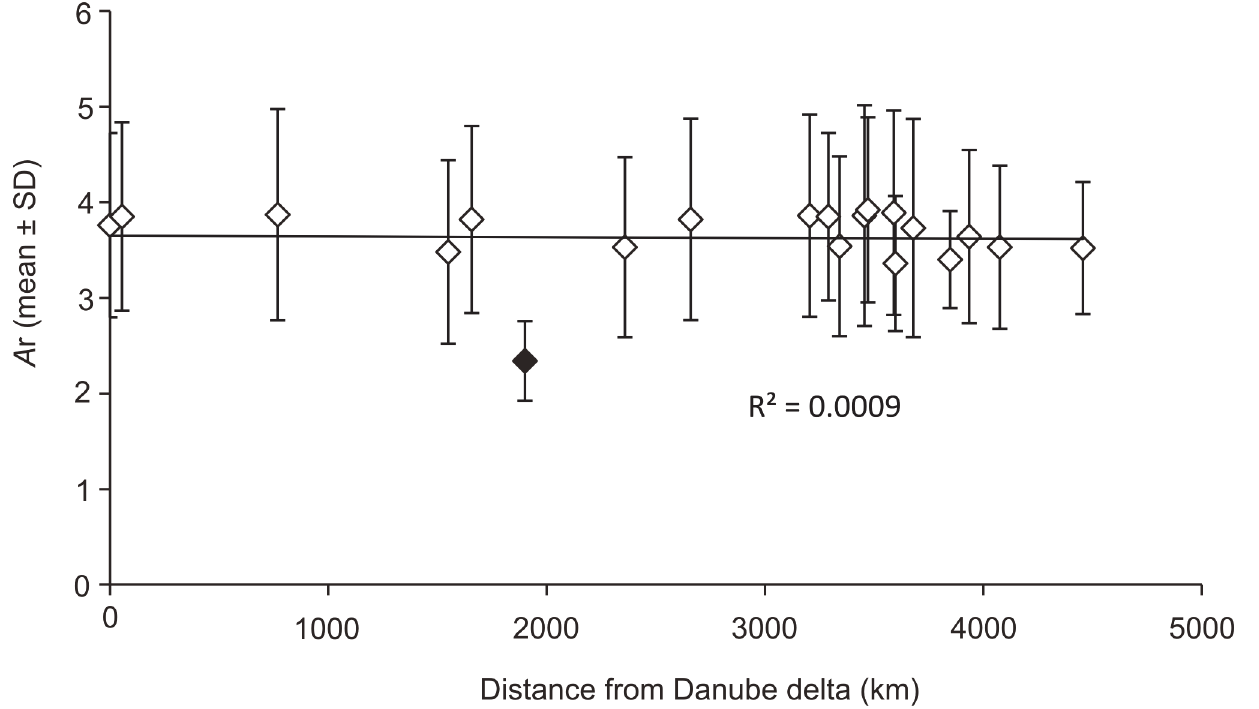
Fig 5. Allelic richness across seven microsatellite loci (mean ± standard deviation) within 20 populations of Dikerogammarus villosus from Western Route (WR) plotted against linear distance from Danube delta to each site along the route (see Fig. 1. for details). Black diamond indicate Vah river site (site 16), see text for details.